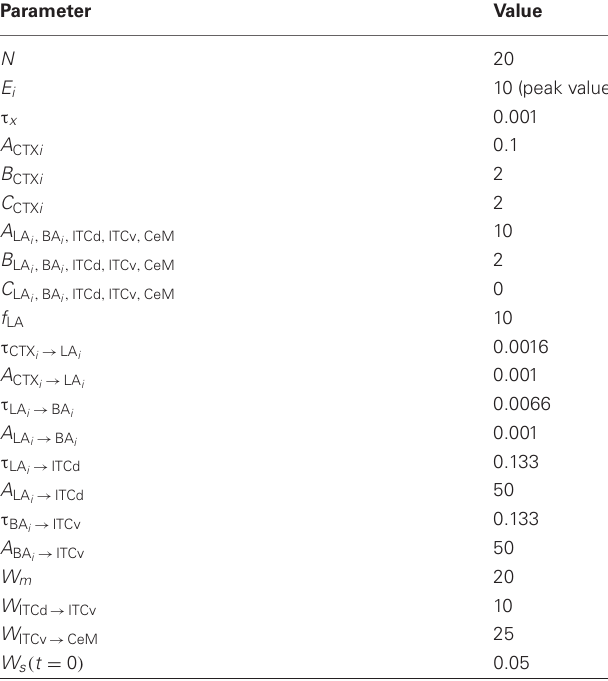
Table A2 | Parameter values common to all